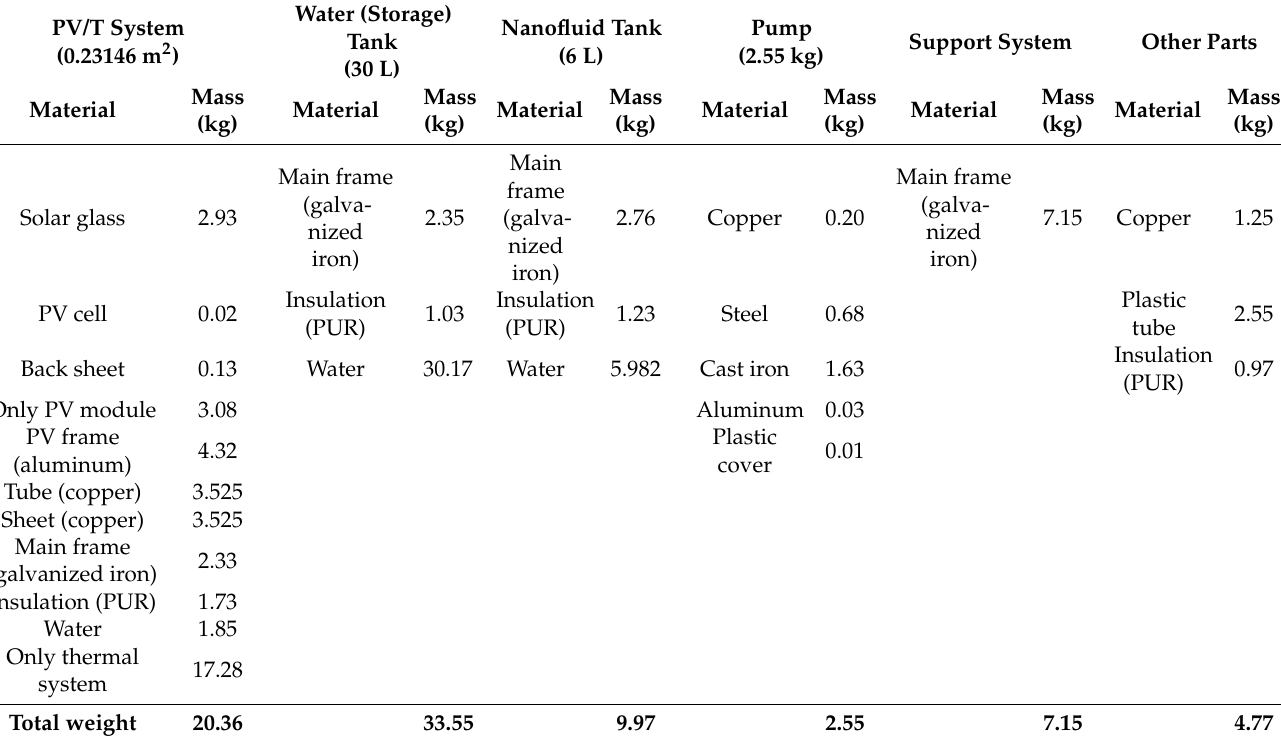
Table 2. Components and their material weights of the whole PV/T system.